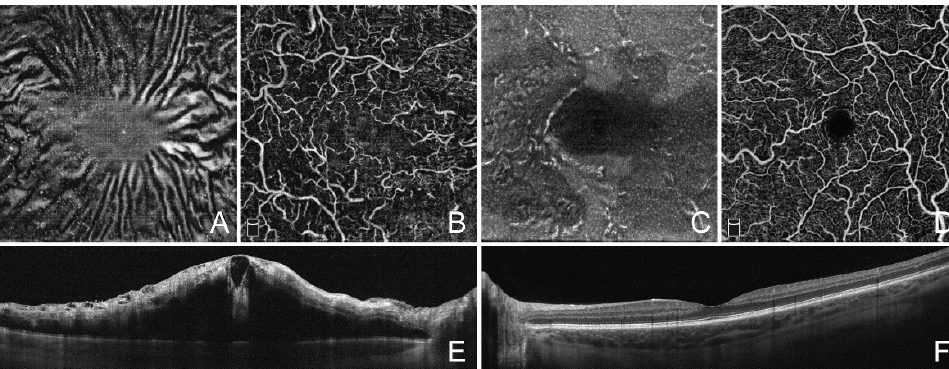
Figure 4. Optical coherence tomography angiography imaging of retinal macrophage-like cells in central retinal vein occlusion. ( A ) Structural en face optical coherence tomography angiography (OCTA) projection displaying macrophage-like cells. ( B ) En face OCTA projection of superficial ca- pillary plexus slab. ( C ) Structural en face OCTA projection in fellow unaffected eye. ( D ) En face OCTA projection of superficial capillary plexus slab. ( E ) Cross-sectional OCT image showing severe macular edema in the affected eye. ( F ) Cross-sectional OCT image showing normal macula in the fellow eye.